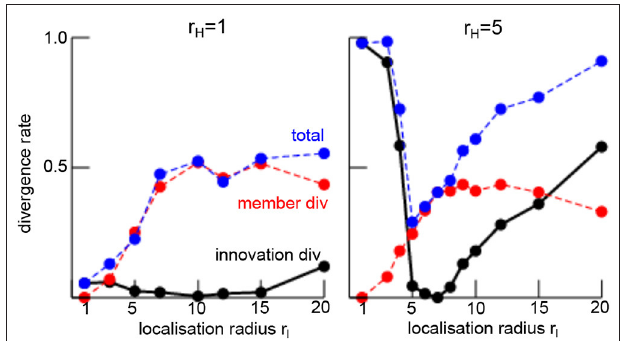
FIGURE 12 | Rate of filter divergence γ (innovation divergence, black line) and catastrophic filter divergence (any ensemble member diverges, red line) in the presence of a single local and a single nonlocal observation. The total number of divergent trials is the sum of innovation and member divergence-trials (blue line). Results are based on 200 numerical